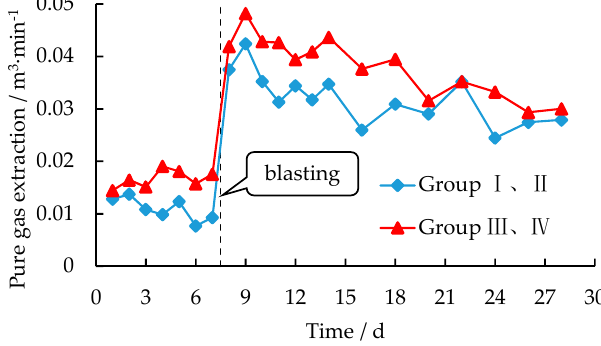
Figure 10. Variation curves of pure gas extraction from boreholes.